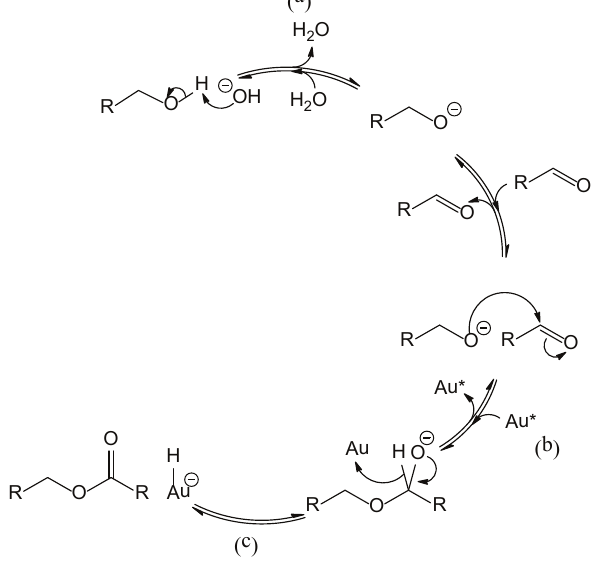
Figure 9. Reaction mechanism of base-catalyzed ester formation from alcohol and aldehyde, adapted from [19]. ( a ) alcohol deprotonation, ( b ) nucleophilic attack of alcoholate on carbonyl, followed by ( c ) β -hydride elimination yields the corresponding ester. The rest of the catalytic cycle consists of the oxidation of the hydride left on the gold surface by molecular oxygen, which also regenerates the base as depicted in Figure 5 (steps f and